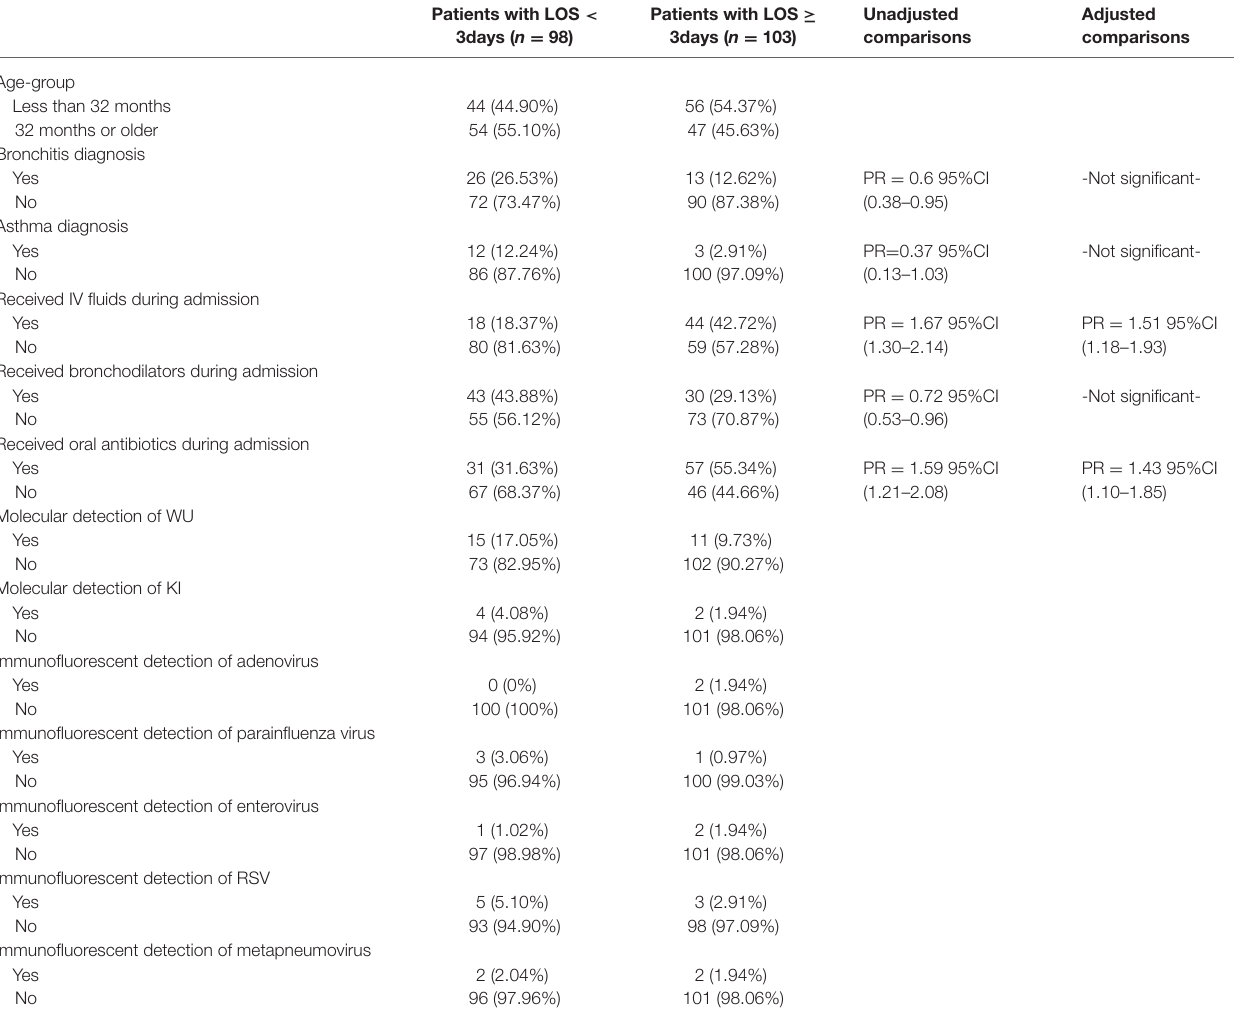
TABLE 4 | Characteristics of 201 pediatric study subjects and an examination of their risk factors in association with length of stay (LOS), Singapore December 2016 to April 2017.